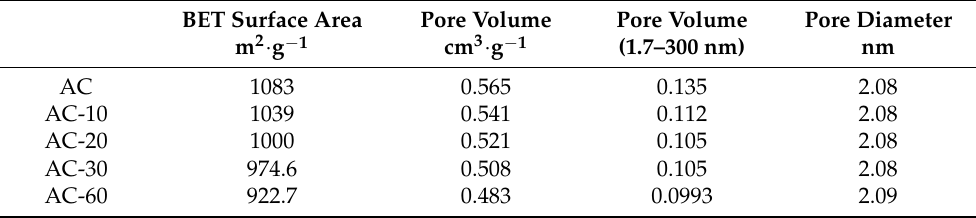
Figure 1. ( a ) Nitrogen adsorption-desorption isotherms of AC and AC-x with different ozone treatment times; ( b ) SEM images of different support: AC (b 1 ), AC-10 (b 2 ), AC-20 (b 3 ), AC-30 (b 4 ), AC-45 (b 5 ), AC-60 (b 6 ).